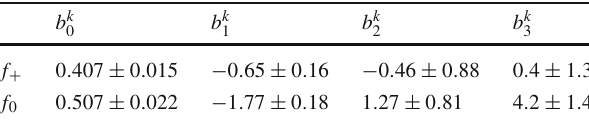
Table 5 Parameters used for the determination of the ¯ B → π(cid:2) − ¯ ν (cid:2) form factors as given in Ref.